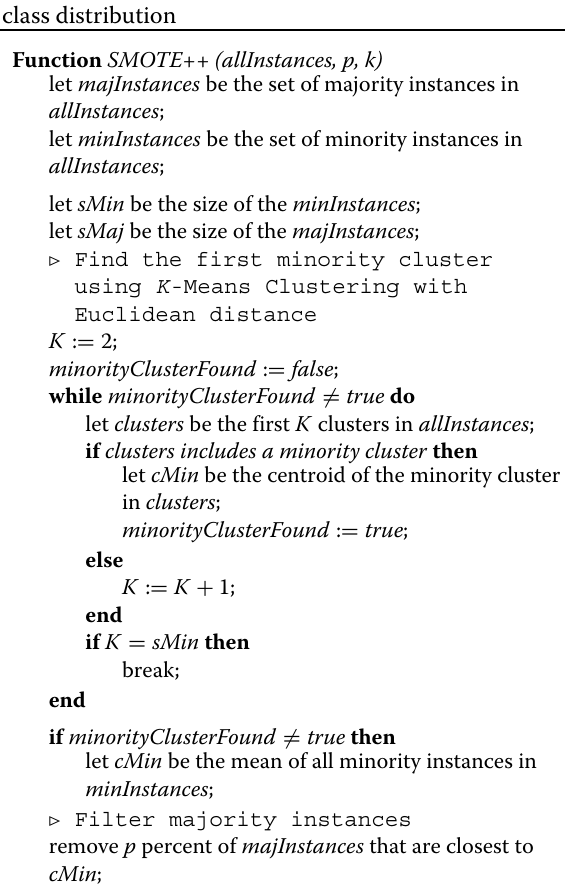
Algorithm 2: The SMOTE++ algorithm. It takes an imbalanced data set ( allInstances ), the percentage